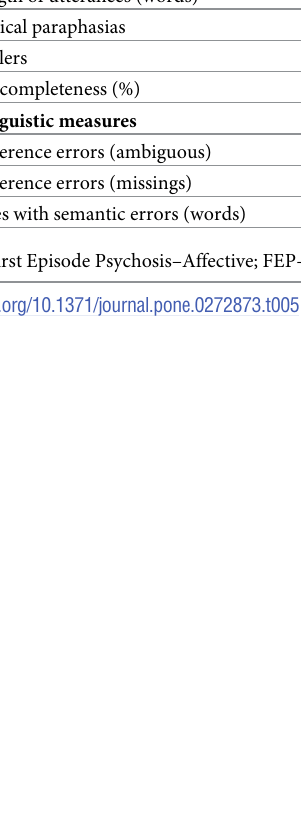
Table 5. Post-Hoc analysis (FEP-A vs FEP-NA).